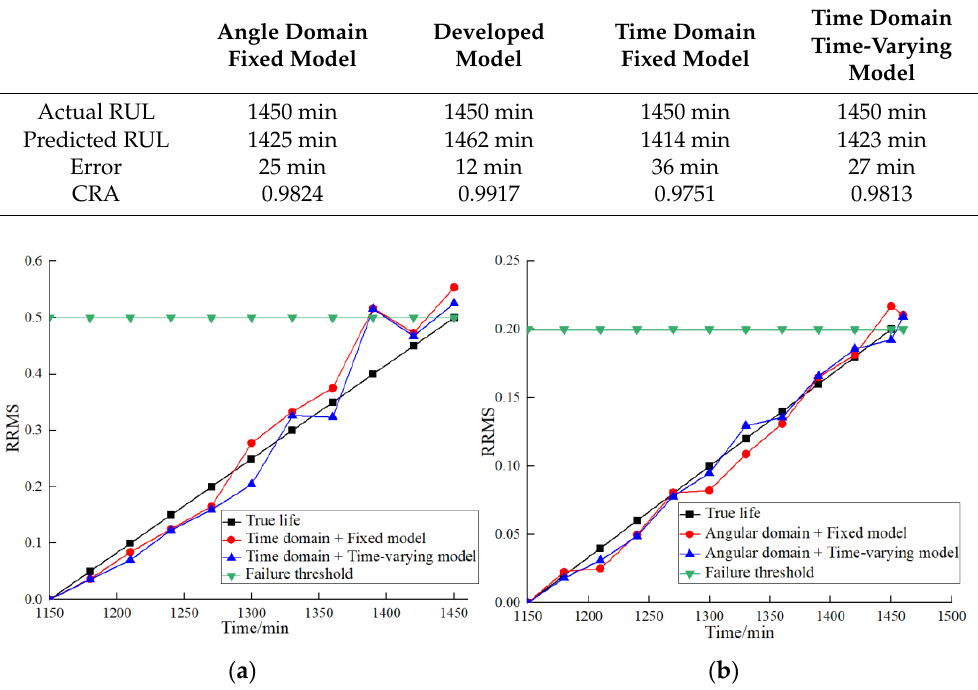
Figure 13. ( a ) Life prediction comparison of two models in the time domain; ( b ) life prediction comparison of two models in the angular domain. Table 5. Comparison of RUL prediction results of four methods.